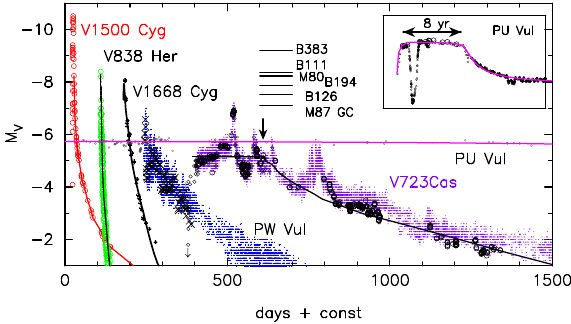
Figure 1: Light curves of various speed classes of no- vae. From left to right, V1500 Cyg, V838 Her, V1668 Cyg, PW Vul, V723 Cas, and PU Vul (horizontal line and inset), which are taken from Kato et al.